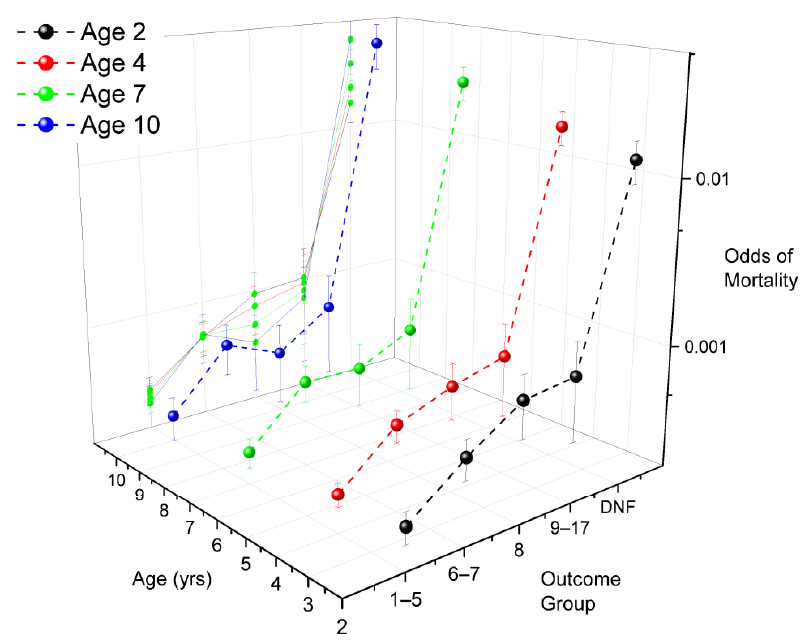
Figure 4. Mortality data from the Ontario Death Registry for work-events involving standardbred horses racing in the Province of Ontario from 2003–2015. Odds of mortality (95% confidence intervals for the mean, unit of interest-work-event), by work-event outcome for AGE groups 2, 4, 7 and 10, describing an AGE × OUTC (outcome) interaction identified through logistic regression analysis. Population-all work-events except scratches in the study period ( n = 1,713,225). Mortality odds are stratified by outcome. Note the tendency for mortality within AGE to increase as finishing position falls back. DNF outcomes consistently have higher mortality odds than all other finishing positions, finish group 1 – 5 consistently has the lowest odds. Table 4. Populations at Risk, Mortality Rates, and Common Presenting Complaints by Outcome and Track Class for Standardbred Racehorse Work-events in the Province of Ontario,